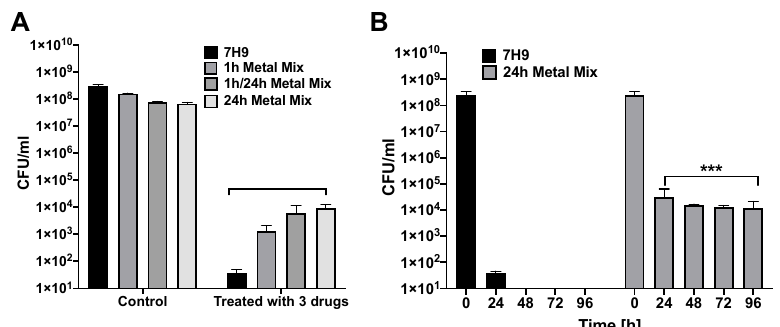
Figure 4. The persistent population of MAH104 produced during combinational antibiotic treatment. ( A ) Approximately, 5 × 10 8 CFU/mL bacteria were cultured either in the 7H9 broth or the 1 h, 1 h/24 h and 24 h metal mix. After 24 h incubation, MAH104 of two phenotypes was subjected to 64 μ g/mL CLA, 64 μ g/mL CIP and 128 μ g/mL RIF combinational treatment for additional 24 h at 37 °C under agitation. No antibiotic treatment within tested conditions served as controls. ( B ) MAH104 was incubated either in the 7H9 broth or the 24 h metal mix and subjected to 64 μ g/mL CLA, 64 μ g/mL CIP and 128 μ g/mL RIF combinational treatment for up to 4 days. After, bacteria were centrifuged, serially diluted and plated on 7H10 agar plates for CFU determination. Data represent the means ± standard deviations (SD) of three independent experiments performed in duplicates. *** p < 0.001 statistical significance within the combinational antibiotic treatment between the 24 h metal mix and 7H9 control group.